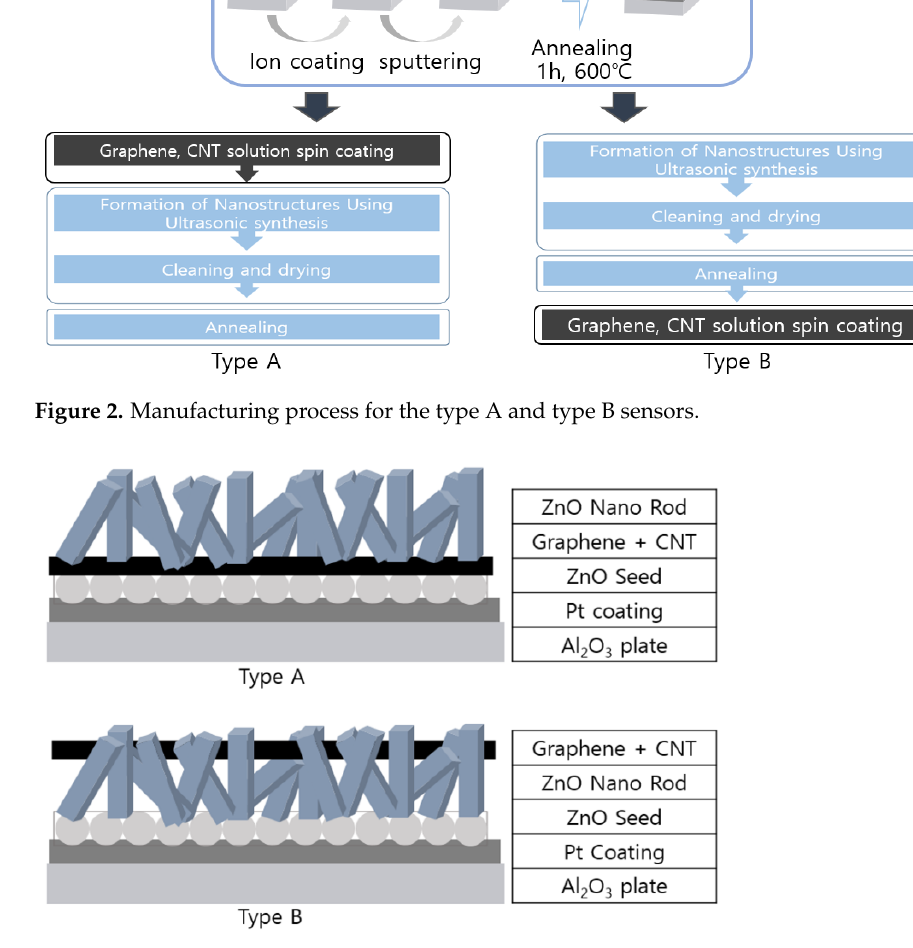
Figure 3. Schematic of the type A and type B sensors.